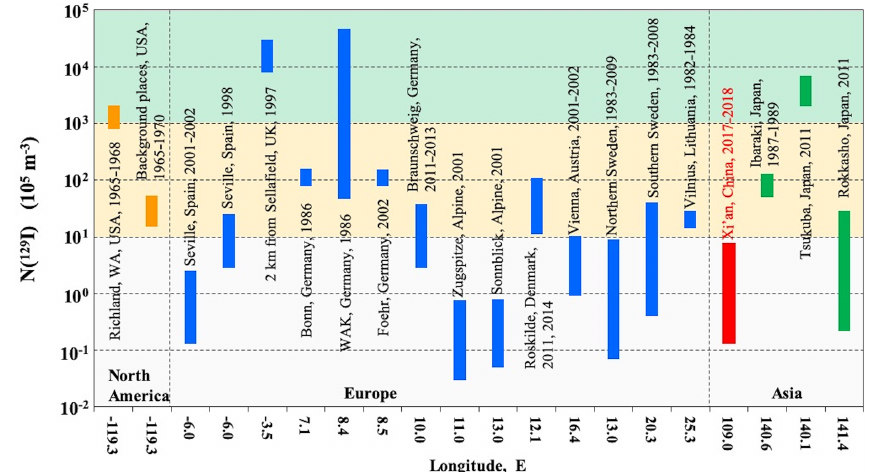
Figure 5. Comparison of aerosol 129 I levels in Xi’an, China (red bars), with other investigations in North America (orange), Europe (blue) and East Asia (Green) distributed by longitude. The green, yellow and white bands are high ( > 10 8 atomsm − 3 ) , middle (10 6 to 10 8 atomsm − 3 ) and low ( < 10 6 atomsm − 3 ) 129 I concentrations in